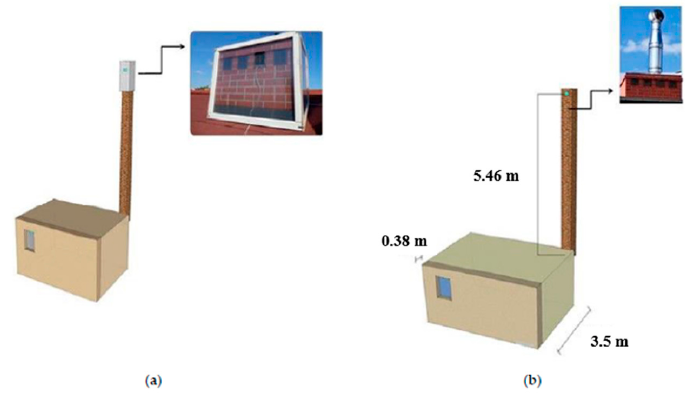
Figure 5. Test room and stack ventilation system, ( a ) TYPE II, ( b ) TYPE III. Table 2. The material and thermal parameters of the partitions in the ventilation system.